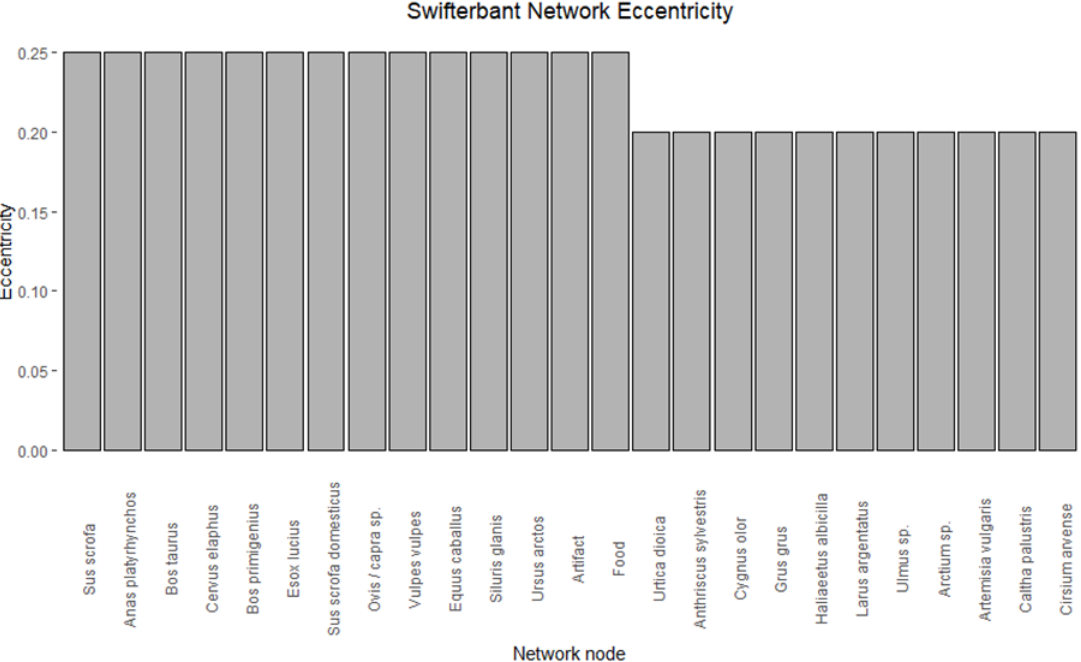
Figure 6. Network eccentricity (top 25).